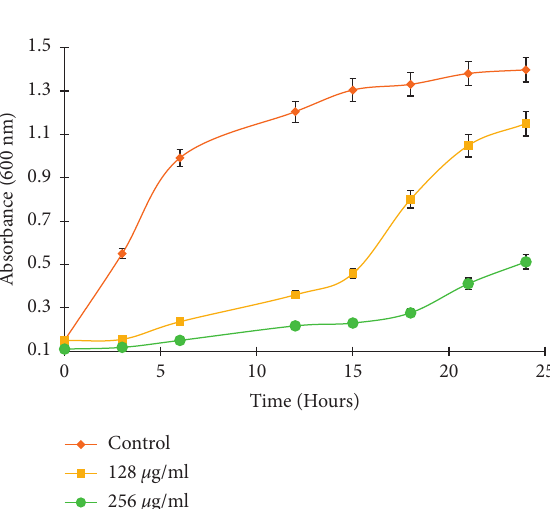
Figure 1: Growth curve of K. pneumoniae with ciprofloxacin treatment (conc. 128 μ g/ml and 256 μ g/ml) and without cipro- floxacin treatment using standard culture conditions. The X -axis represents time (hours), whereas the Y -axis shows the absorbance ( λ � 600nm).